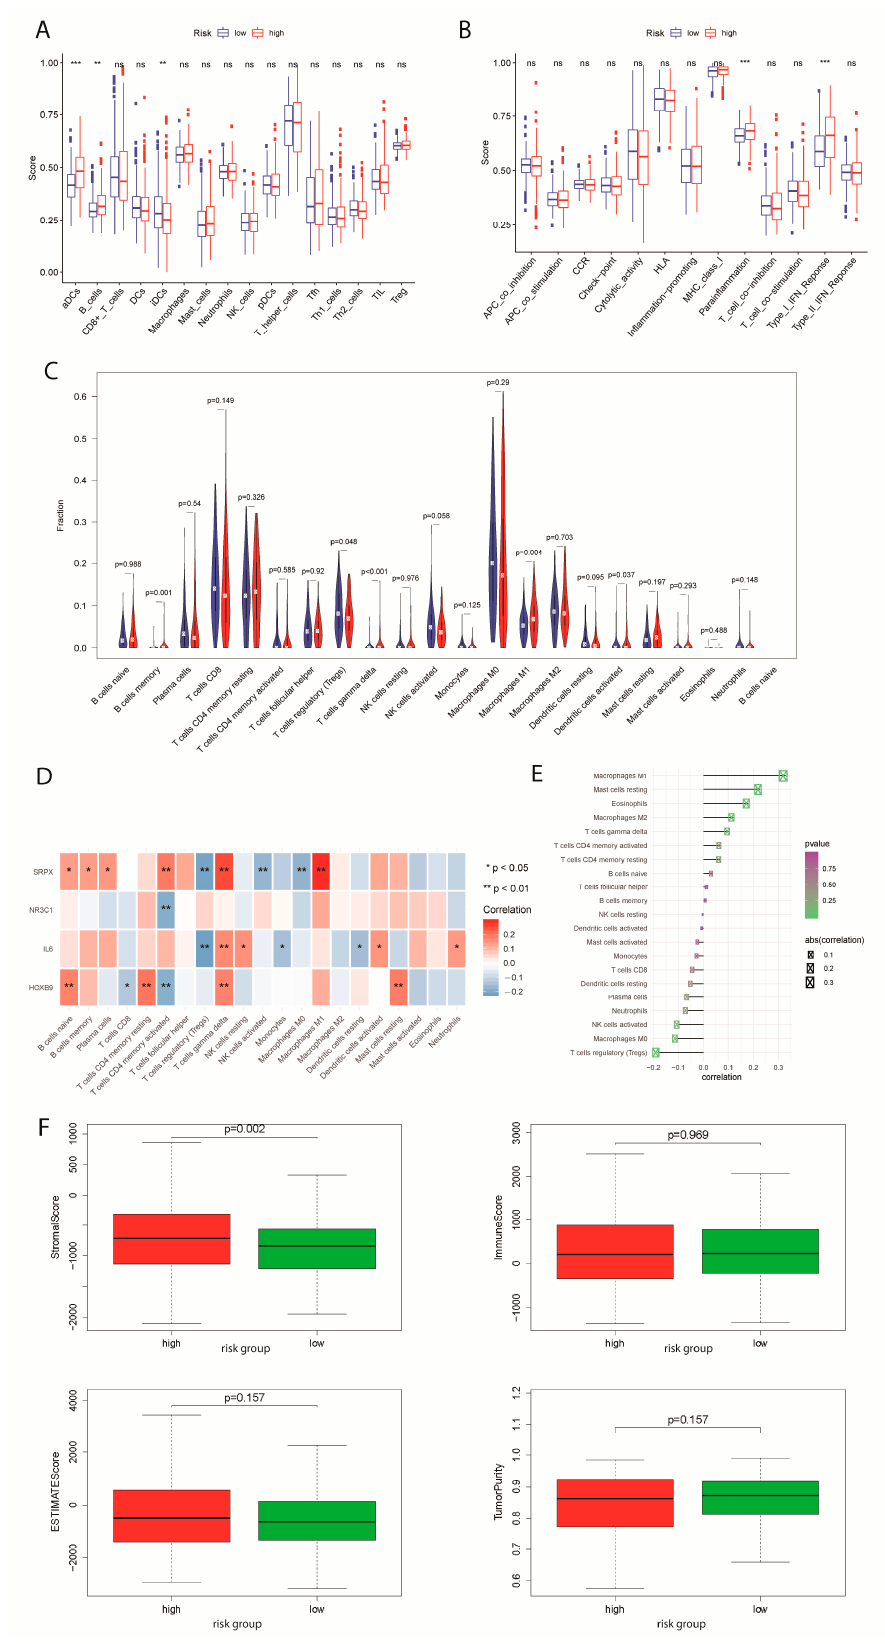
Figure 3. Infiltrating immune cells and tumor cell mRNA modifications correlated with hypoxia- related DEGs in EC patients. ( A ) The function scores of twenty-two immune cell types in EC